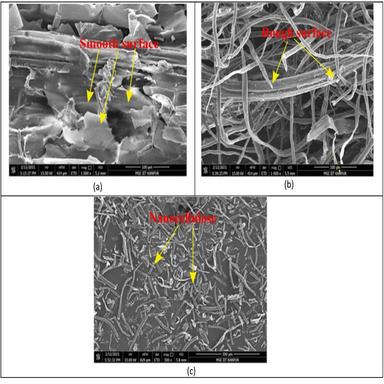
FESEM image of wheat straw: (a) untreated (b) alkali treated and (c) nanocellulose.